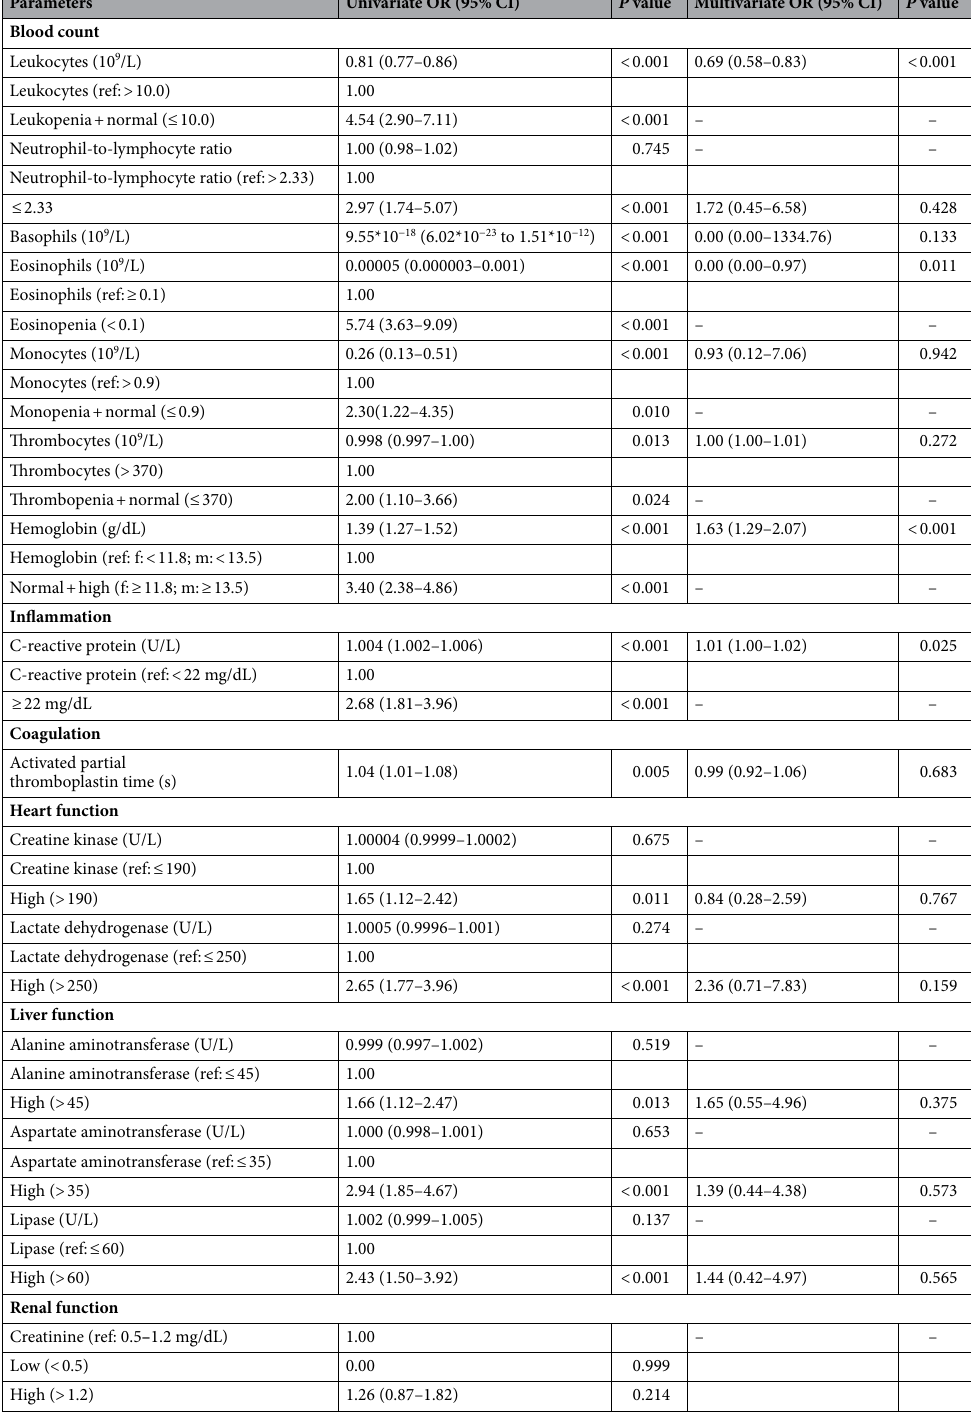
Table 4. Uni- and multivariate analyses of standard blood laboratory parameters with COVID-19 positive tested patients as the dependent variable. Abbreviation: CI confidence interval, OR odds